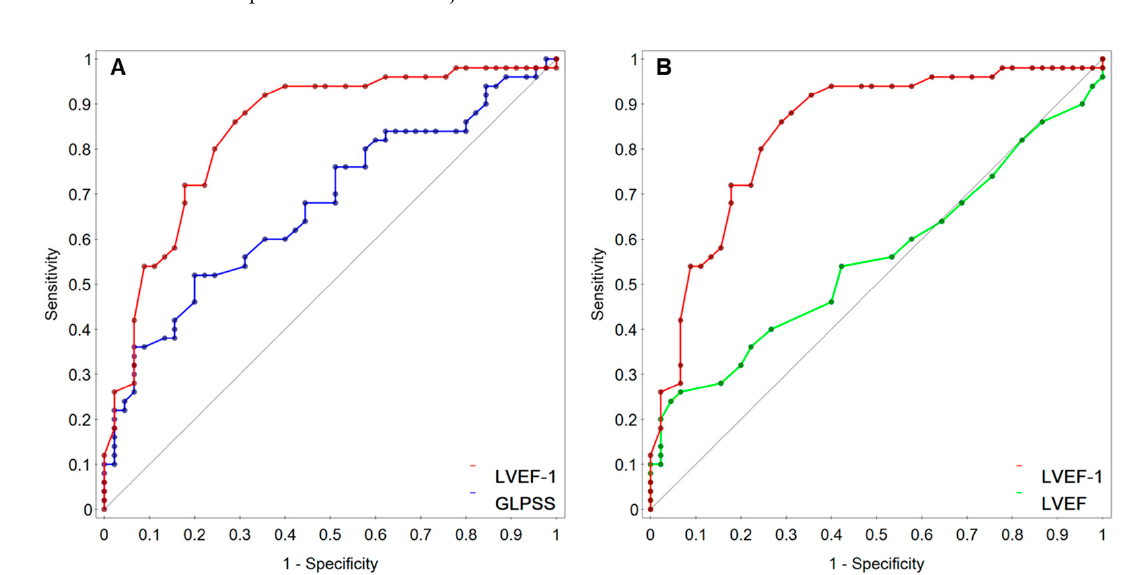
Figure 1. Comparisons of AUCs (area under the curve) for LVEF-1 (first-phase ejection fraction) with GLPSS (global longitudinal peak systolic strain) (A) or LVEF (left ventricular ejection fraction) (B).